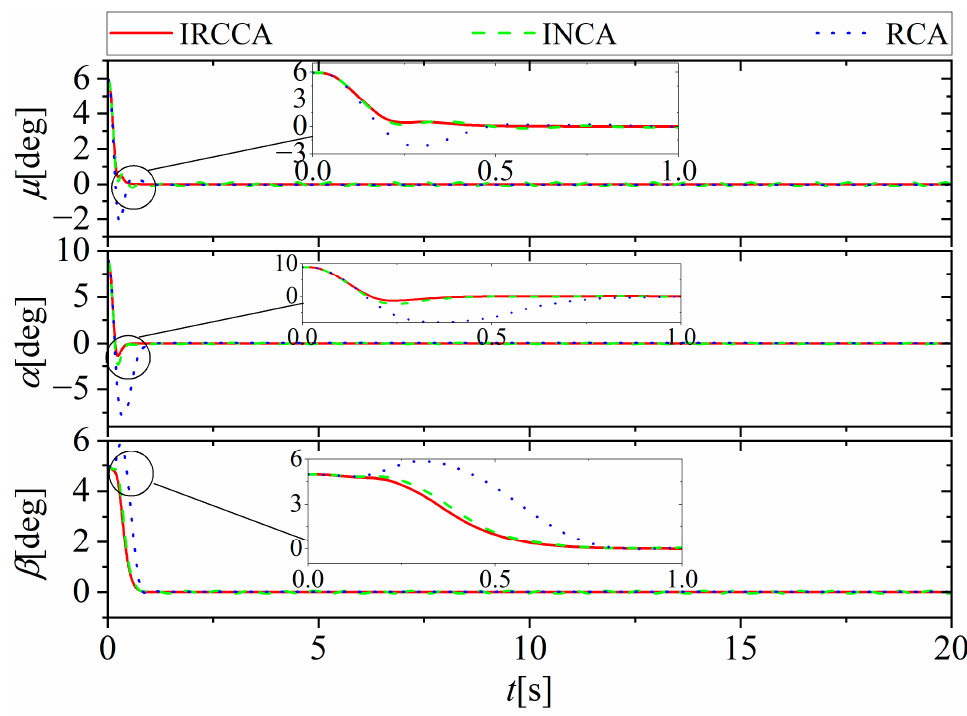
Figure 9. Time response of the attitude angle with loose fault.